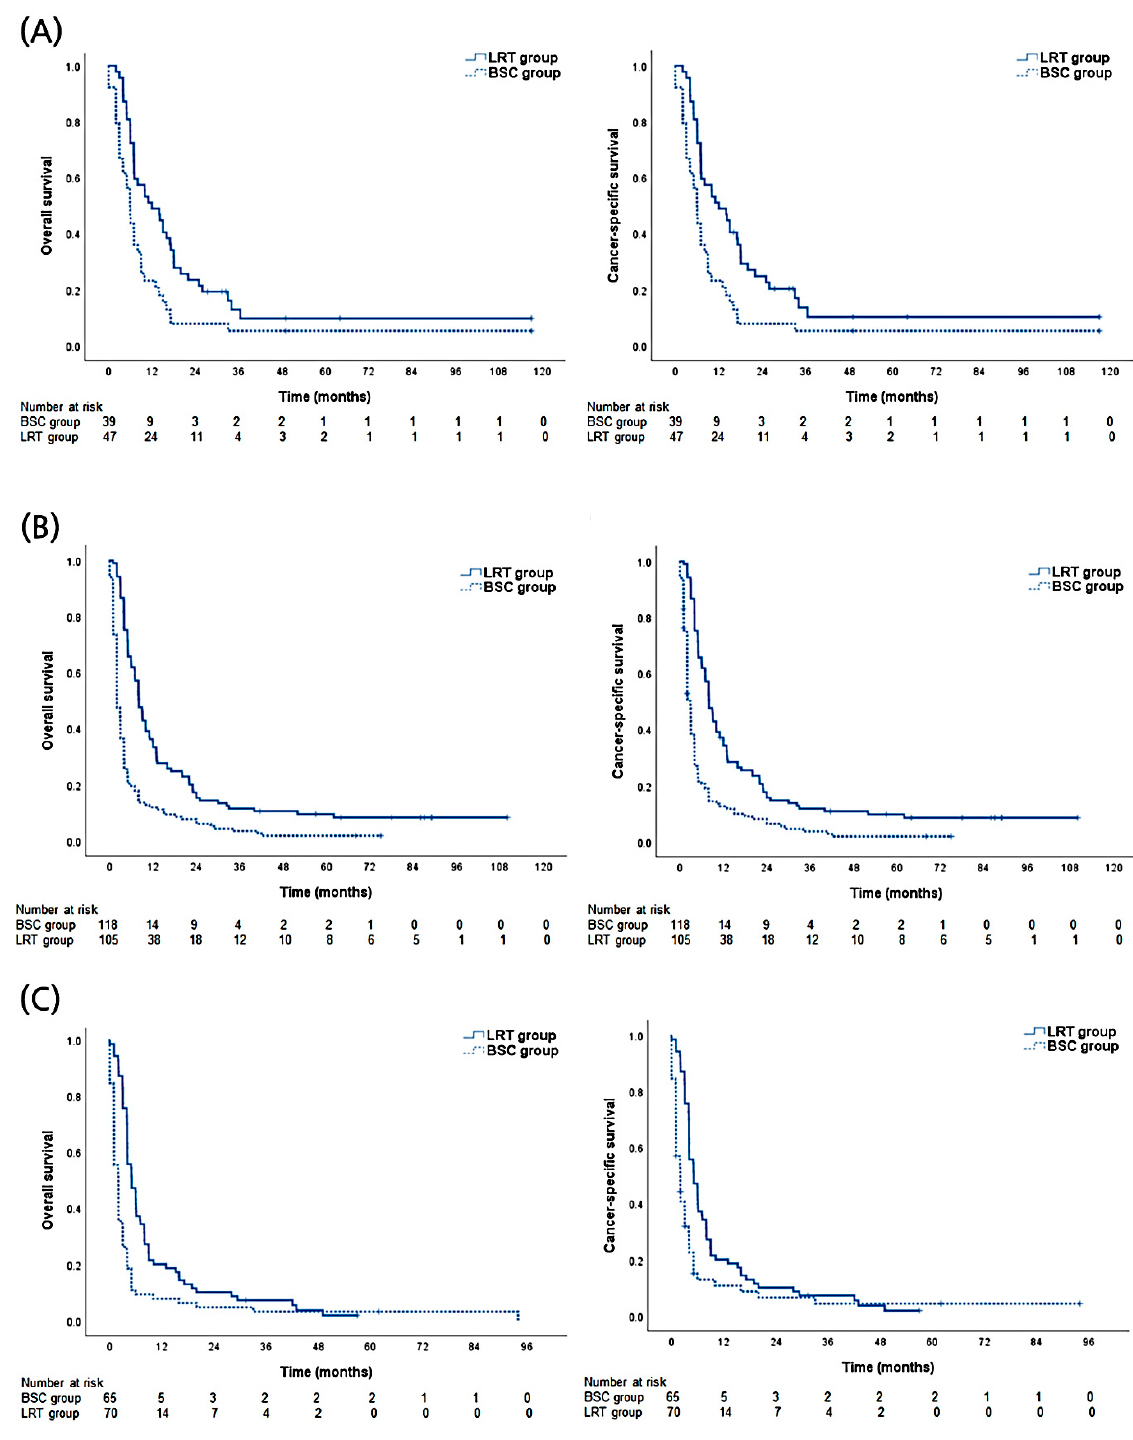
Figure 3. Descriptive graphs of overall and cause-specific survival according to treatment modalities (local treatment including radiotherapy [LRT] versus best supportive care [BSC] groups) of ( A ) Child-Pugh class (CPC) and albumin-bilirubin index (ALBI) A1 group. ( B ) CPC-ALBI A2 group. ( C ) CPC-ALBI B or higher group.